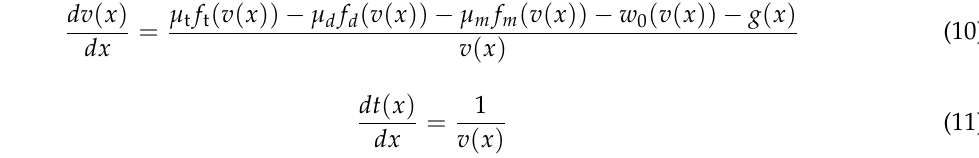
(cid:105) / M and g curve ( x ) =